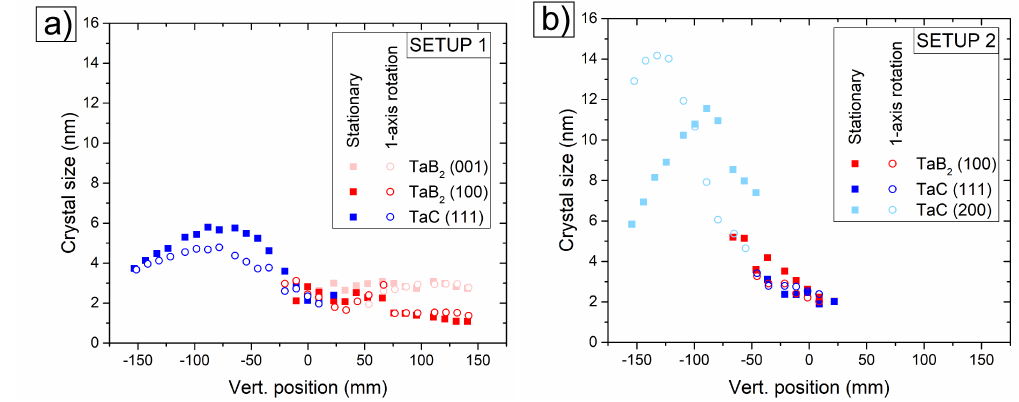
Figure 9. Crystallite sizes calculated from all peaks allowing for reliable fitting: ( a ) Setup 1; ( b ) Setup 2.